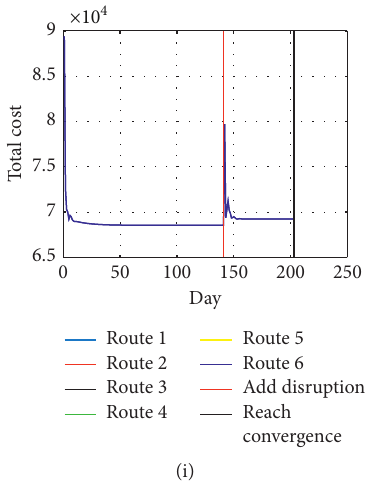
Figure 5: Evolution of route costs, route flow, and total cost evolution under different levels of disruptions when the P0 ASC is employed. First row (from (a) to (c)): the evolution of route costs, route flow, and total cost when the capacity of link 9 reduces by 25%; second row (from (d) to (f)): the evolution of route costs, route flow, and total cost when the capacity of link 9 reduces by 50%; third row (from (g) to (i)): the evolution of route costs, route flow, and total cost when the capacity of link 9 reduces by